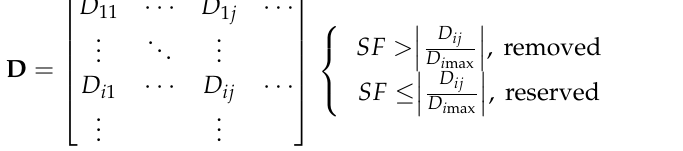
( b ) ( c ) Figure 7. Numerical model of magnetic part. ( a ) Coil and straight wire; ( b ) Magnetic core with air gap; ( c ) Position relationship between coil and core.